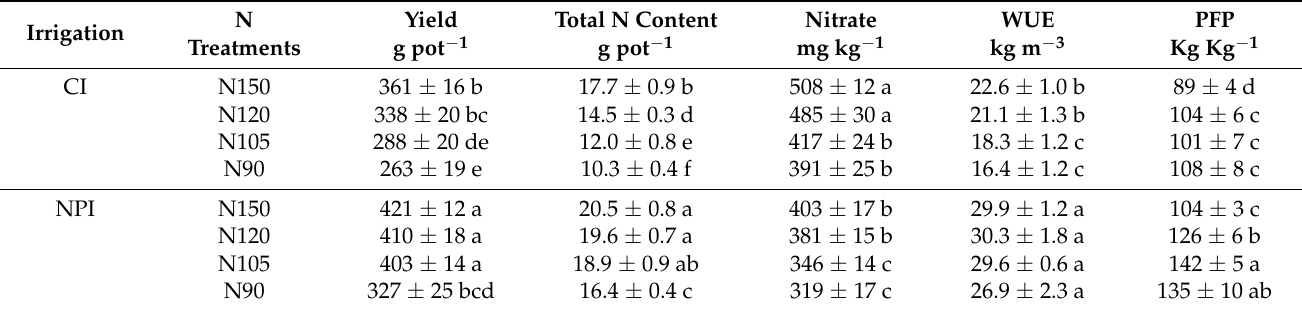
Table 1. Performance of lettuce under different irrigation and N treatments in Experiment 1.